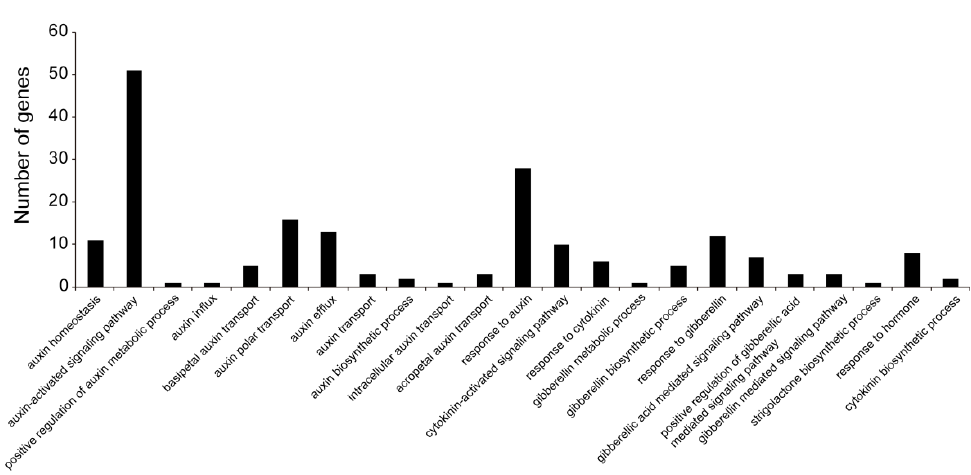
Figure 2. GO classification of DEGs associated with hormone regulation. The horizontal axis lists the names of the 23 GO terms in the biological process category.